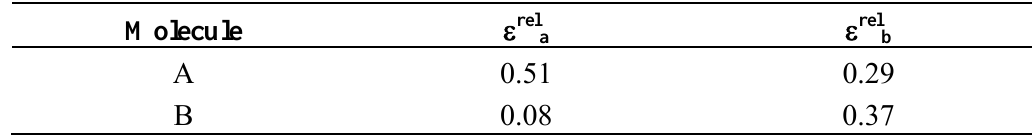
Table 2. Estimated relative molar extinction coefficients of the molecules A and B in the crystal for the incident beams with polarization directions parallel to the a-axis (  rel ) traveling in the direction normal to the (001) the b-axis (  rel b